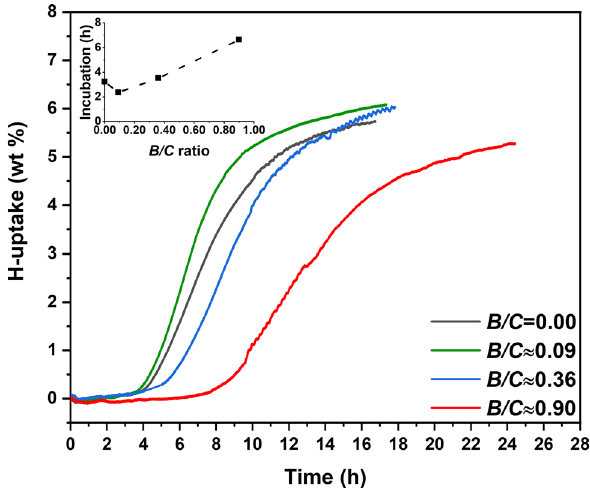
Figure 1. H-uptake (wt %) versus time (h) in ball milled Mg-B-erGO nanocomposites at various B/C ratios obtained at ~ 15 bar, ~ 320 °C. Inset shows the incubation time (h) plotted against B/C